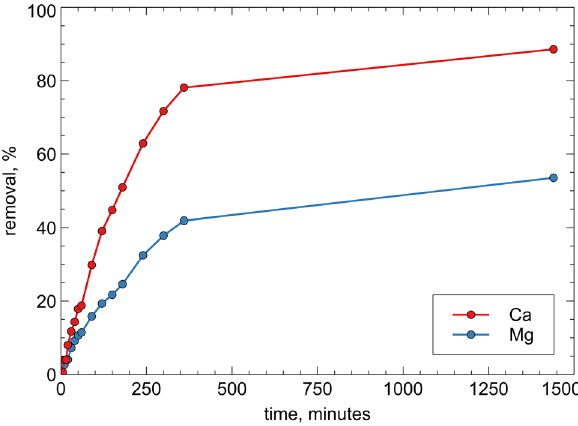
Figure 4. ZEOP calcium and magnesium uptake kinetic under uncontrolled pH conditions.